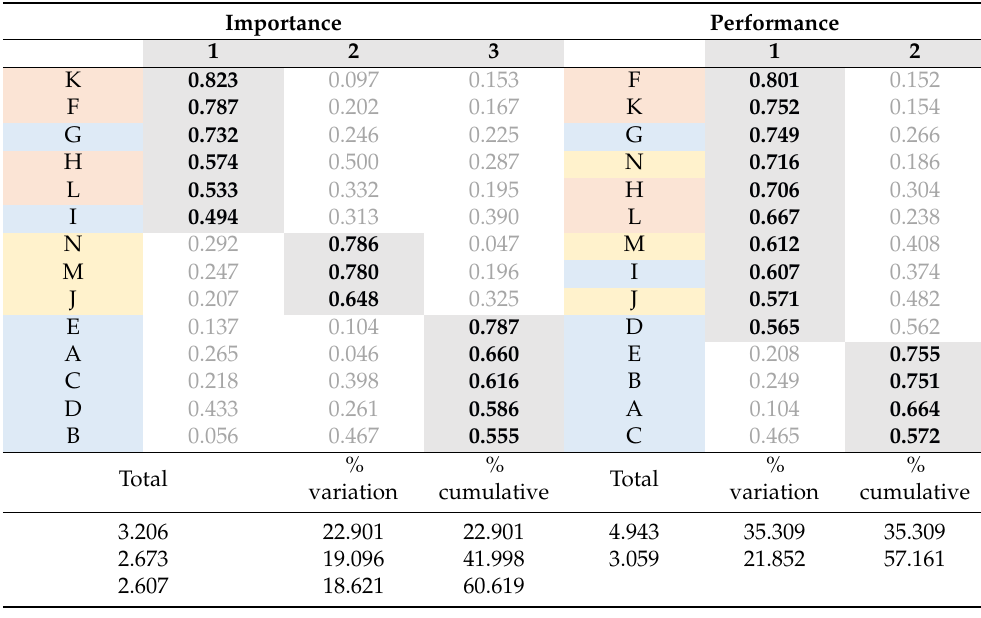
Table 11. Factor analysis (older adult